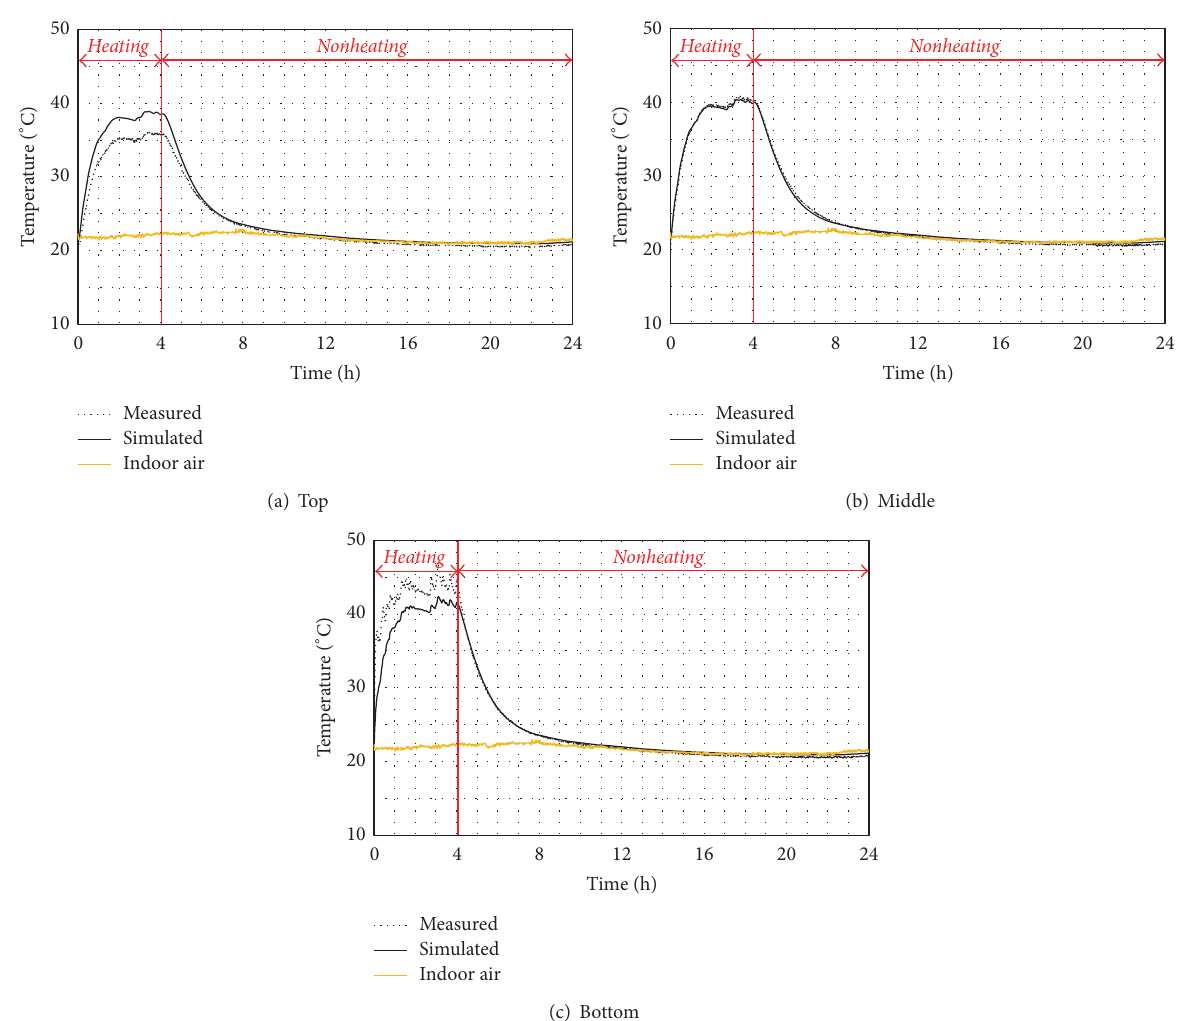
Figure 6: Temperature distributions of simulation and experimental values for